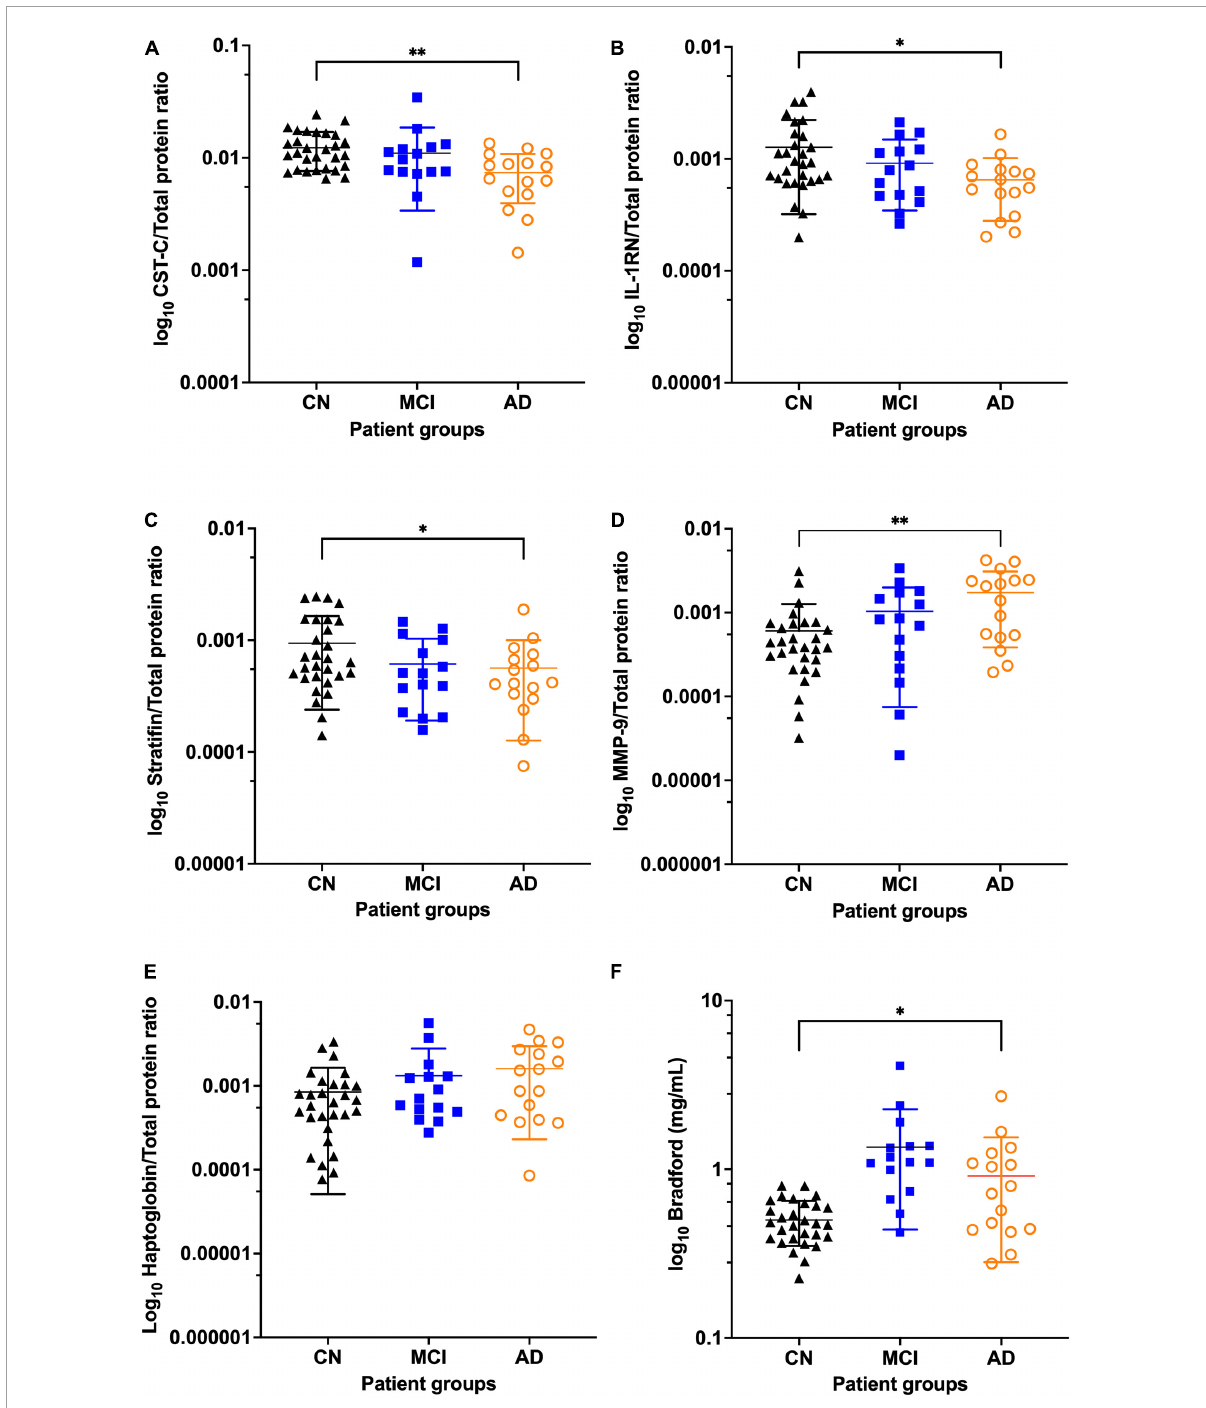
FIGURE1 Levels of total protein and five biomarkers in the SANDs cohort showing reduced abundance of CST-C, IL-1RN, and SFN in MCI and AD and increased abundance of total protein, MMP-9 and HP in MCI and AD. Scatter dot plots show the mean, standard deviation and all points for each biomarker adjusted for total protein with AD in orange ( n = 16), MCI in blue ( n = 15) and CN in black ( n = 29) for (A) CST-C (B) IL-1RN (C) SFN (D) MMP-9 (E) Hp (F) Total protein. ∗ Unadjusted p -values shown from log transformed data for cohorts CN vs. AD with ∗ P < 0.05 and ∗∗ P < 0.01. AD, Alzheimer’s disease; CN, Cognitively Normal; CST-C, Cystatin-C; Hp, Haptoglobin; IL-1RN, Interleukin-1 receptor antagonist protein; Matrix metalloproteinase 9, MMP-9; MCI, Mild cognitive impairment; SFN,